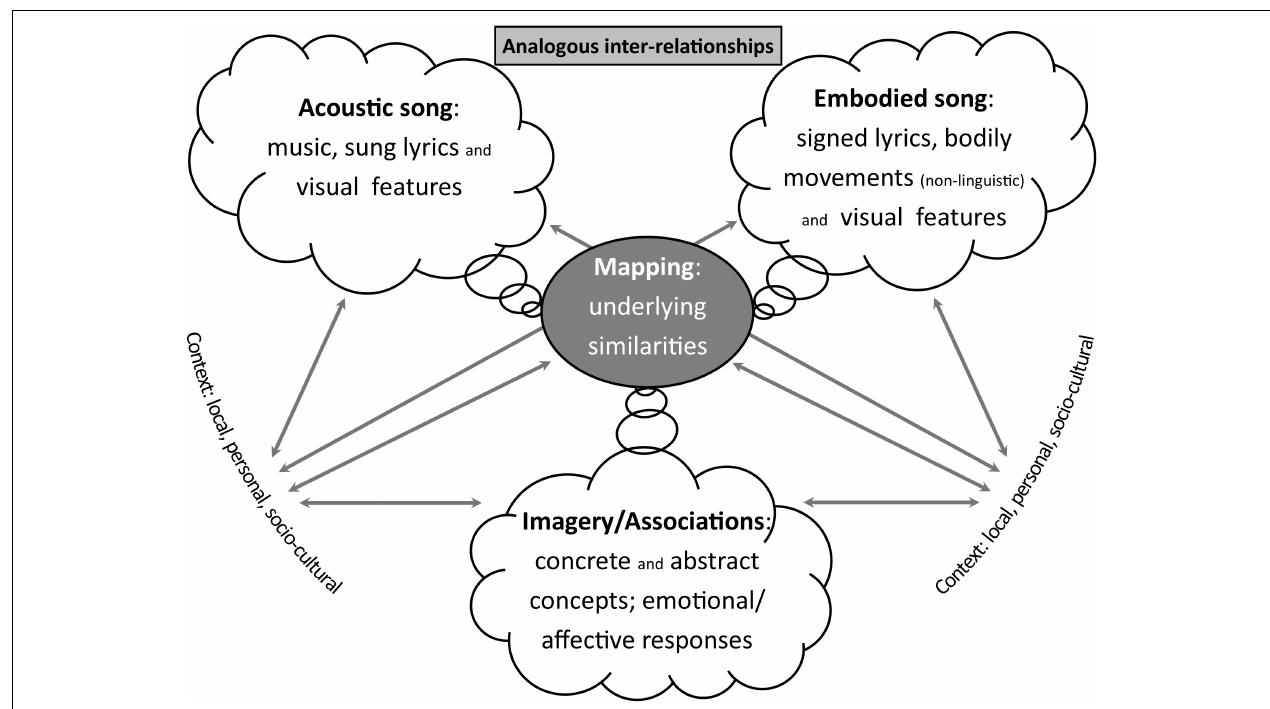
FIGURE 7 | Analogous inter-relationships—analogies in different modalities are linked by the mapping of their underlying similarities; choices and attention are influenced by